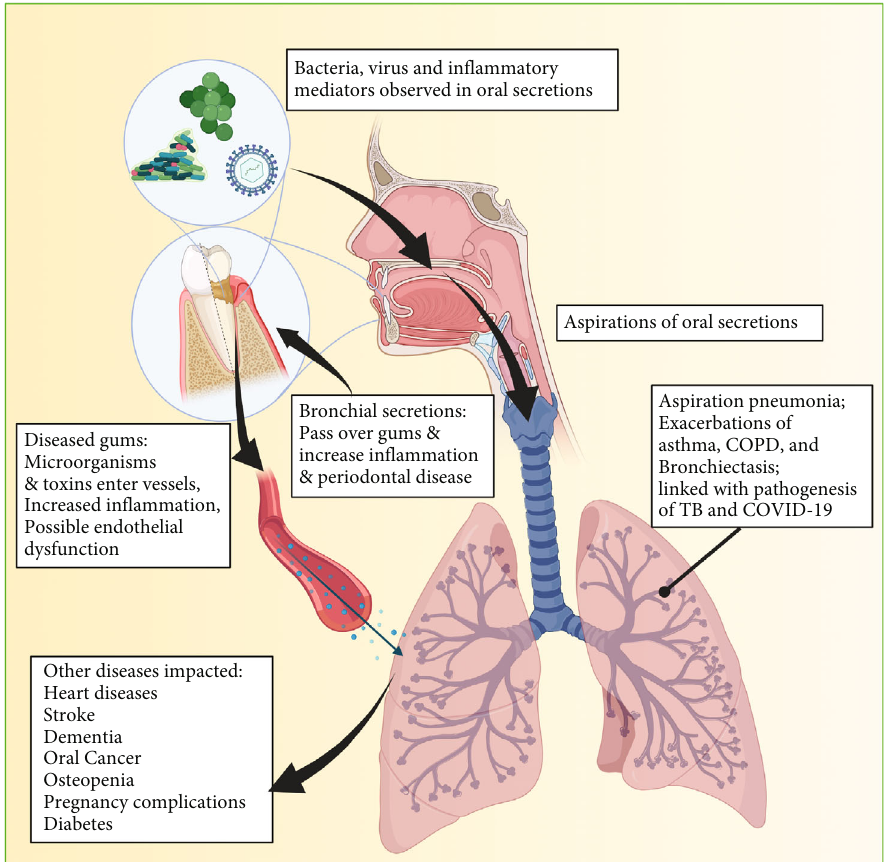
Figure 1: Possible interactions associating periodontal diseases with pulmonary diseases. Created with